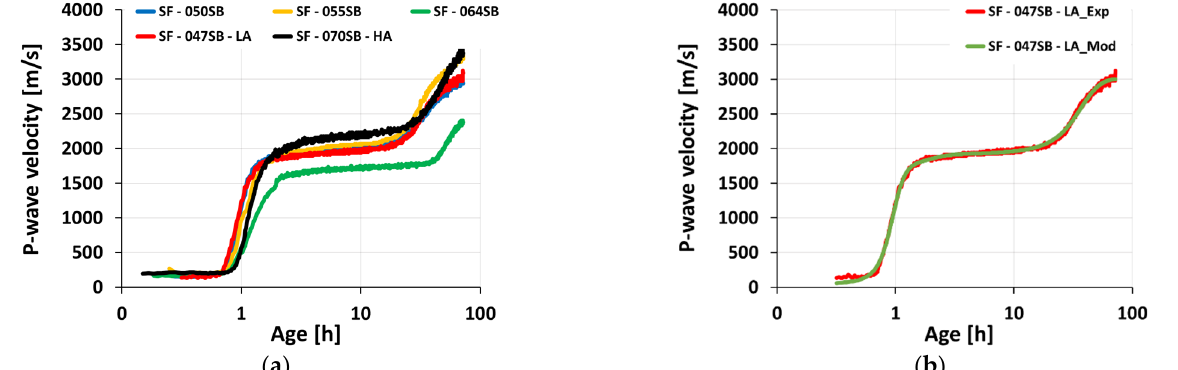
Figure 7. UPV evolution as a function of age: ( a ) all studied mixes in logarithmic scale; ( b ) reference modeled UPV curve for mix SF—047SB—LA.